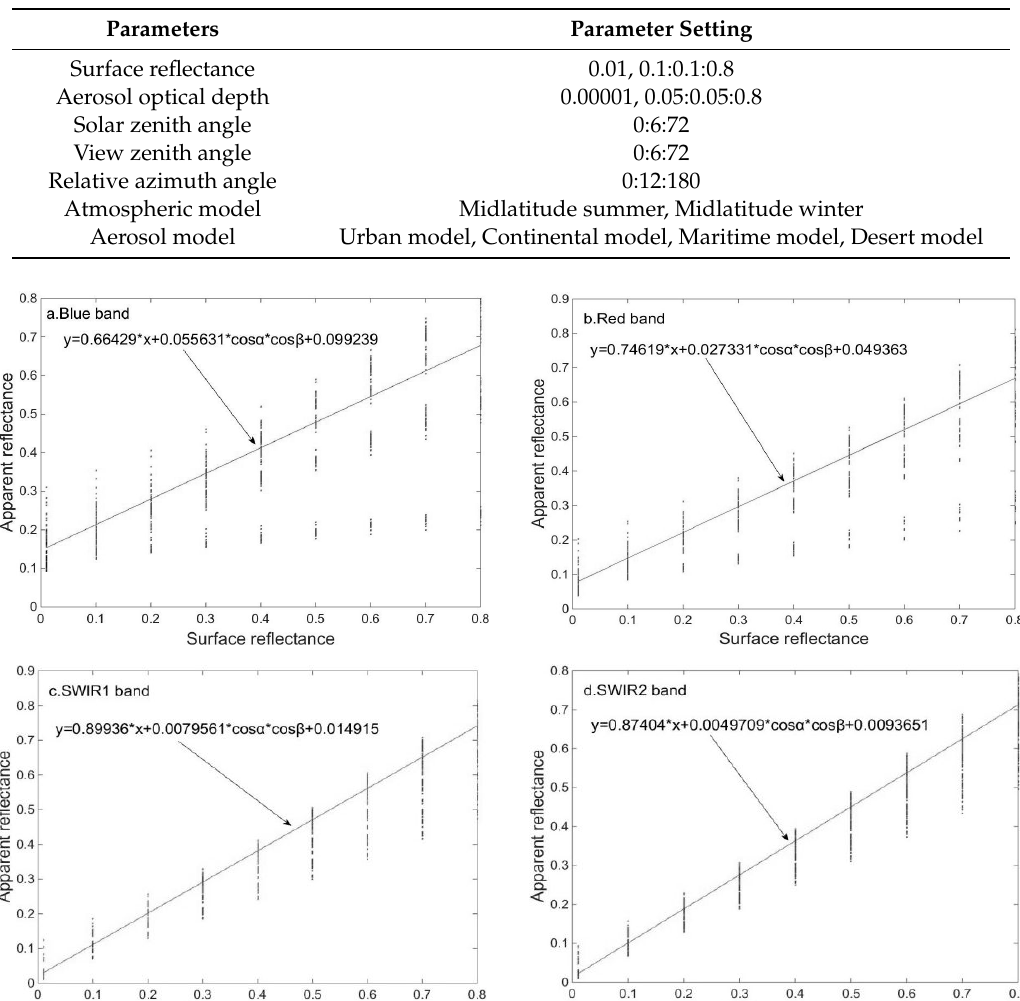
Figure 3. Relationships between the surface reflectance and apparent reflectance under different solar and satellite azimuth angles. ( a ) Blue band; ( b ) Red band; ( c ) SWIR1 band; ( d ) SWIR2 band.